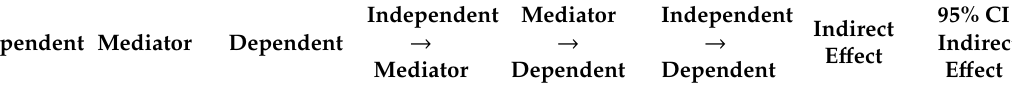
Table 5. Indirect e ff ects by group, unstandardized coe ffi